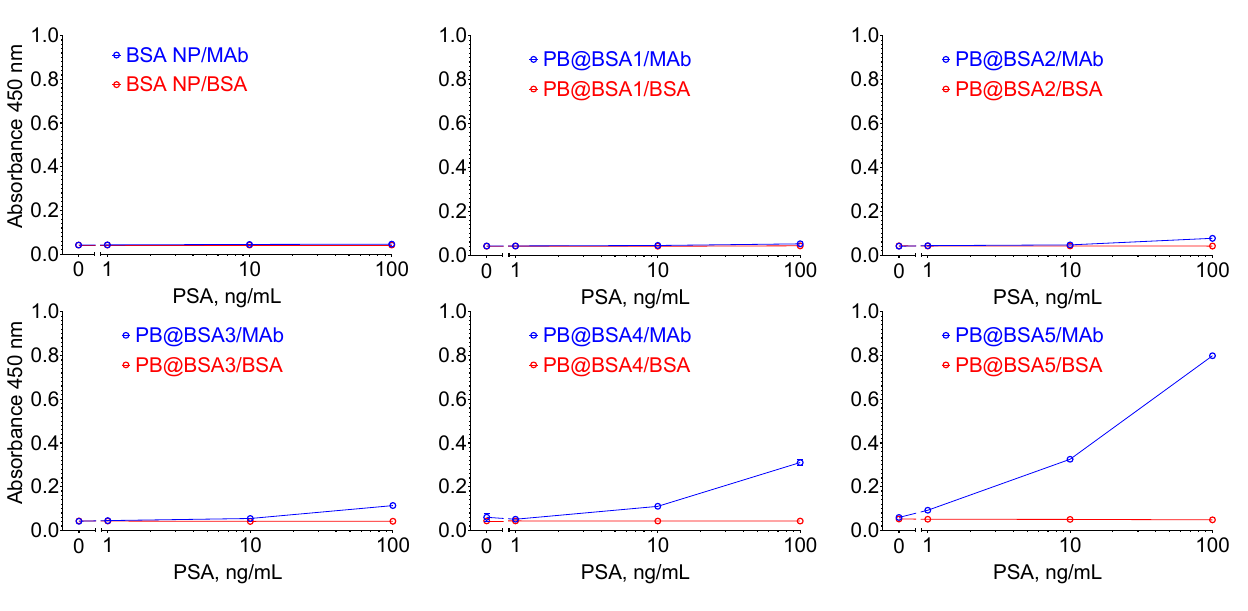
8 of 13 Figure 3. Colloidal stability of PB@BSA5/Str. ( A ) Mean hydrodynamic diameter (Dh) and polydis- persity index (PdI) of nanoparticles (10 μ g/mL) in McIlvaine buffers with various pH values. ( B ) Zeta potential of nanoparticles (50 μ g/mL) in 5 mM citrate-phosphate buffer. Means ± SDs of 3 tech-